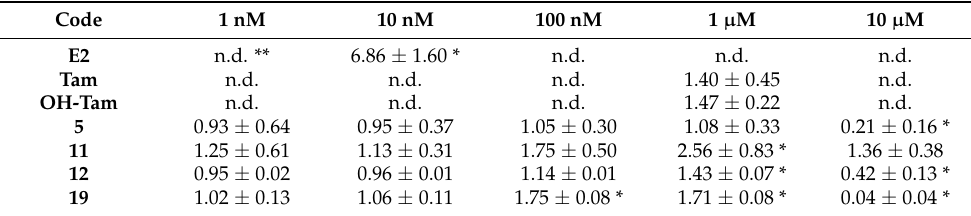
Table 6. Relative alkaline phosphatase activity after an incubation of 72 h in Ishikawa cells.